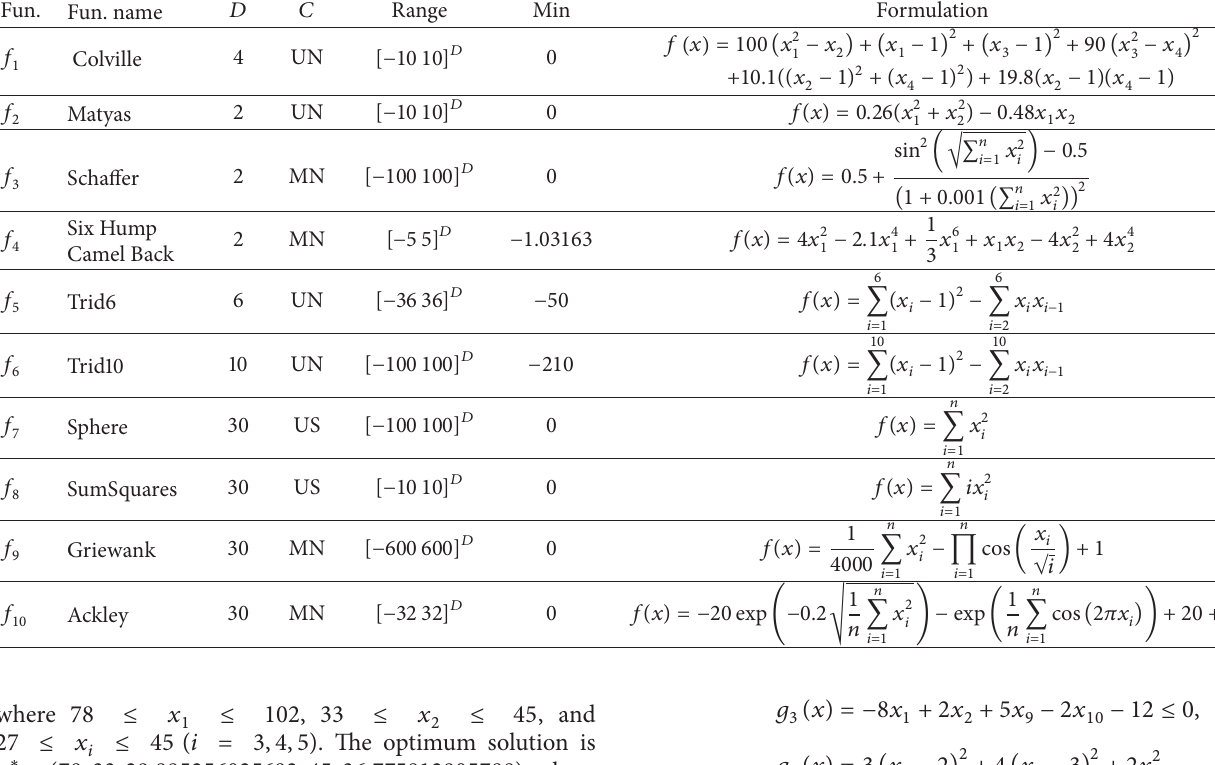
Table 8: Unconstrained global optimization problems (Set-1) used in our